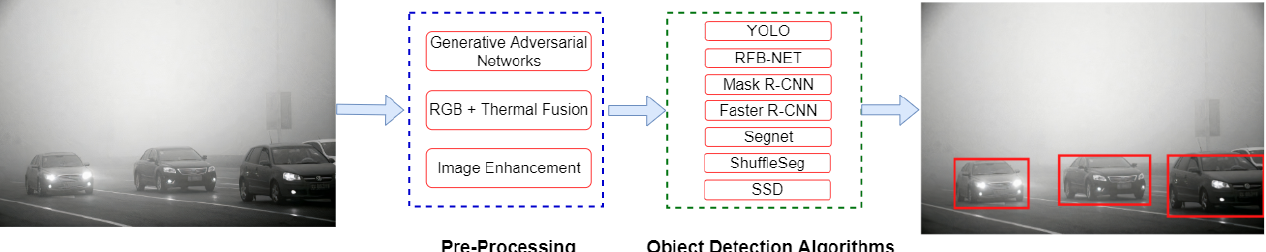
Figure 7. The generic mechanism of the proposed approaches that have tackled the problem of object detection in a challenging environment. Image-enhancement networks extract important features from the input images. Object detectors employ these features to retrieve final